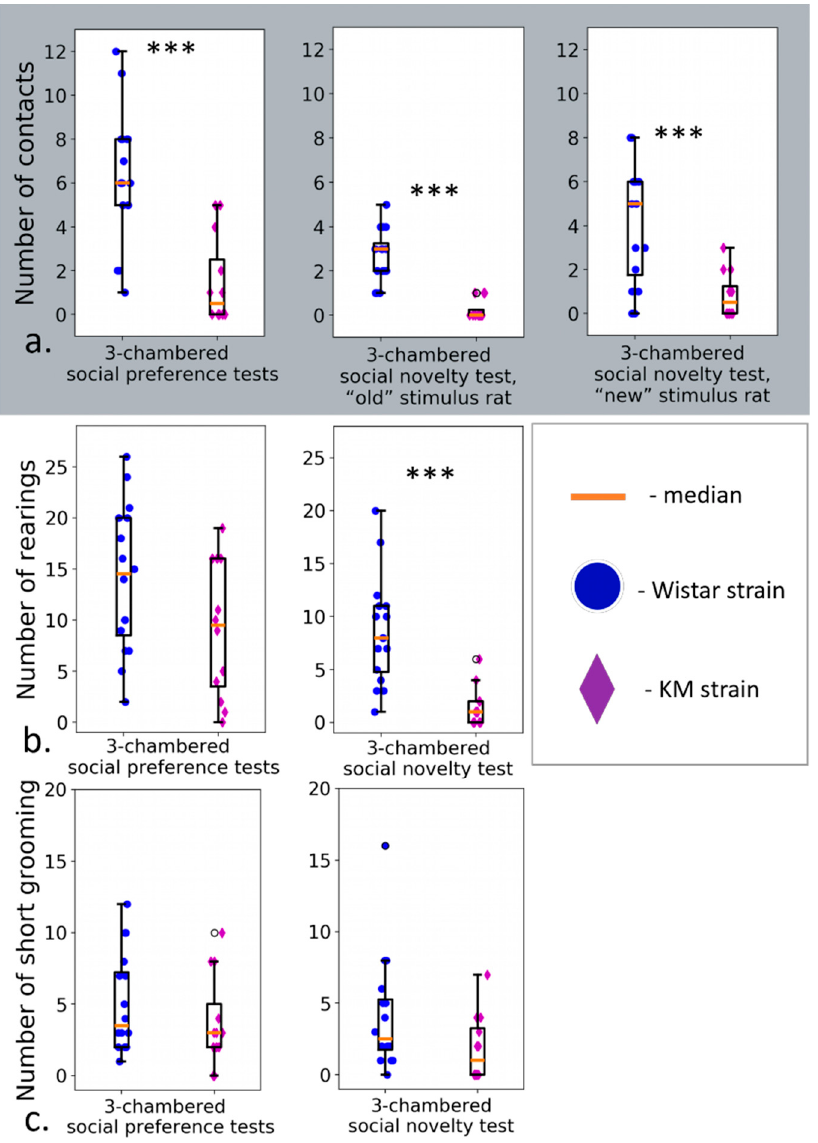
Figure 5. Numbers of all types of contacts were lower in KM group compared to Wistars ( a ). Rearings ( b ) were reduced, and short grooming bouts ( c ) did not change ( c ) in KM rats (violet diamonds) compared to Wistar rats (blue circles) in the social preference/social novelty tests. Data are represented as the box plot and whiskers (indicating variability outside the upper and lower quartiles). Statistical significance is indicated as follows: *** p < 0.001 .